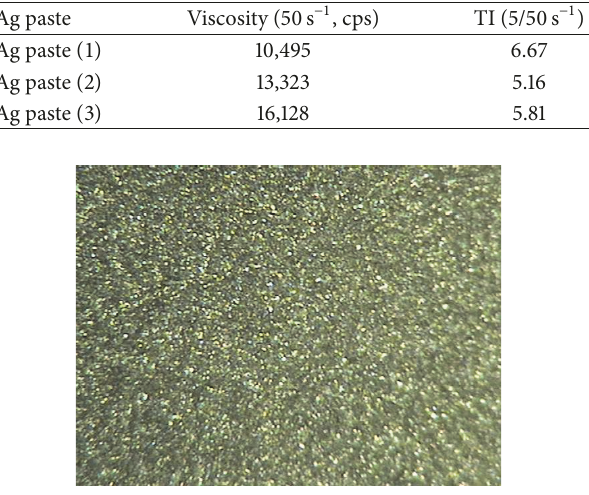
Figure 5: Optical microscope image of screen printed Ag electrode ( × 600) by using Ag paste (1) . Figure 6: Storage moduli and loss moduli versus shear stress plot of